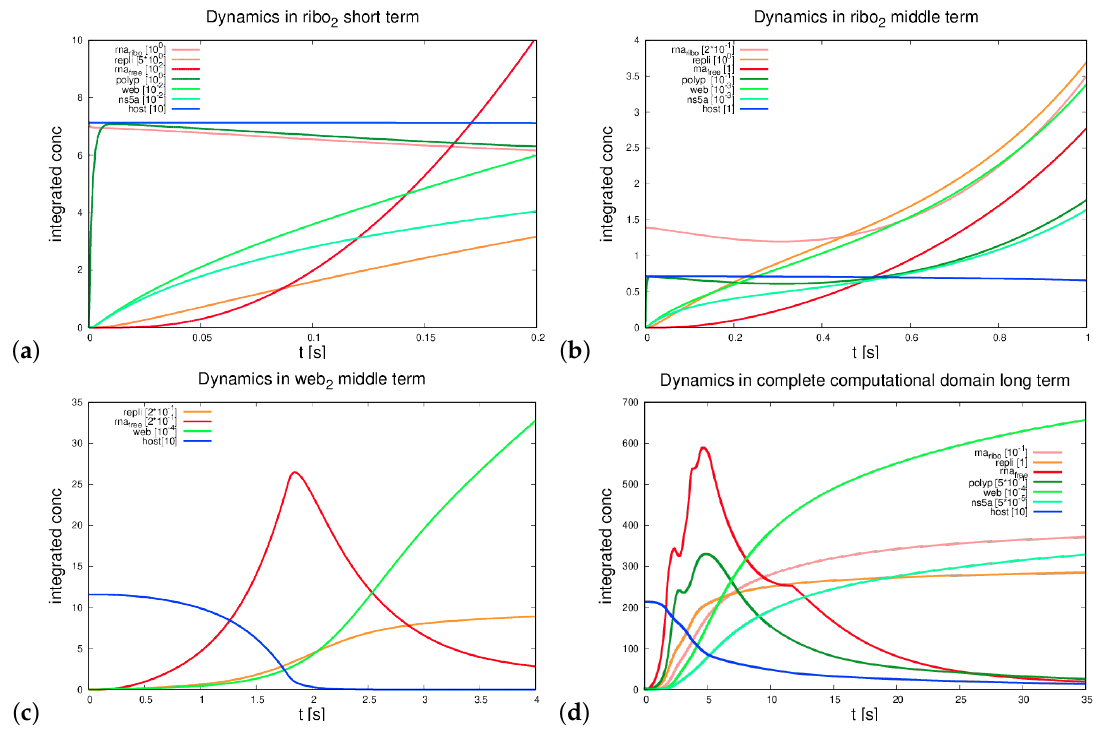
Figure 6. Evaluation of the integrated concentrations (Equation (13)) of the components of the basic sPDEs (Equation (5a)–(5g) with initial conditions in Equation (7a)–(7c), using the test parameters, as indicated in Tables 2 and 3) in different subdomains: ( a ) ribosomal region # 2 ( R 2 ) short term; ( b ) ribosomal region # 2 ( R 2 ) middle term; ( c ) MW region # 2 ( W 2 ) middle term; and ( d ) complete computational domain ( D ) long term (cf. Sections 2.9 and 3.4) Results are shown at grid refinement level 4. The graphs of this figure depict the evaluation of the integrals of the concentrations (Equation (13)) over time for different species. The time is shown at the x -axis. The integrals of the concentrations are shown at the y -axis. The integrals of the concentrations are the sum of each component within their respectively-defined region. The four graphs consider the integrals within different time scales and also within different geometric regions. The integrals are computed within the indicated regions. For example, the integral of ( a ) is computed over the ribosomal region #2, R 2 , therefore the integral reads as given for this special case in Equation (12). The other regions are also indicated within the title of the graphics ( a – d ), cf. Equation (13). The consideration of different time scales allows for consideration of the processes at different temporal resolution, namely for considering the processes structure at special regions at the beginning of the cycle, for example how the HCV RNA translates polyprotein and how the polyprotein splits at the very beginning (cf. ( a )). The split of the polyprotein causes the appearance of web (accumulating) protein and NS5a. In ( b ), we consider the process for a longer time scenario. In, ( c ) the consequences at the surrounding web region, i.e., the dynamics of the concentrations in the web #2, W 2 , which grows on top of the ribosomal region # 2, are considered. We observe the uprise of free RNA, which is produced by the RC, until when the host factor is depleted. Then, locally, free RNA decreases again. The decrease of ribosomal bound RNA at the beginning corresponds with RC creation, while ribosomal bound RNA rises up again once free RNA is produced substantially. We note that the integral of graph ( d ) is performed over the complete computational domain D . The last graph ( d ) shows the sum of each component within the complete part of the cell we consider. We see the uprise of free HCV RNA, and we also observe the staircase similar steps when the next web region is reached. Then, free RNA is sequestered by the ribosomes, and new polyprotein arises which splits again into NSPs to continue the cycle. The host factor depletes more and